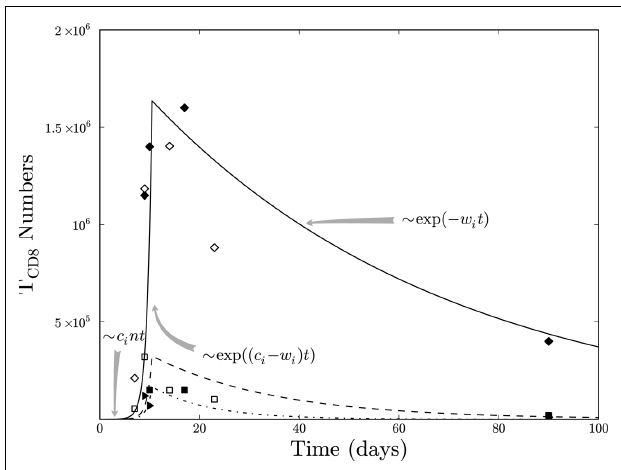
FIGURE 4 | Simulated (lines) and experimental (symbols)T CD8 s in response to the immunization ofWT mice withTag-transformed cells. The response of site I-, II/III-, IV-, andV-specificT CD8 s is shown by the solid, dashed, dash-dot, and dotted lines, respectively.The gray arrows represent the terms in the mathematical model dominating the dynamics.The data from Mylin et al. (2000); empty symbols) and current study (filled symbols) representing site I (squares), II/III (triangles), and IV (diamonds) specific T CD8 s is shown.The data from Mylin et al. (2000) is scaled by a multiplicative factor to minimize the variation between the two experiments.The initial conditions were,T CD8 s = 0, andTag-expressing cells (non-proliferating) = 10 6 . The parameter values are n = 5 × 0.3/1/4 proportion for siteV/I/IV respectively, b = 0.50/day, c = 1.08/day, w I = 0.04/day, w II/III = 0.09/day, w IV = 0.02/day, w V = 1.02/day, α i = 1E100